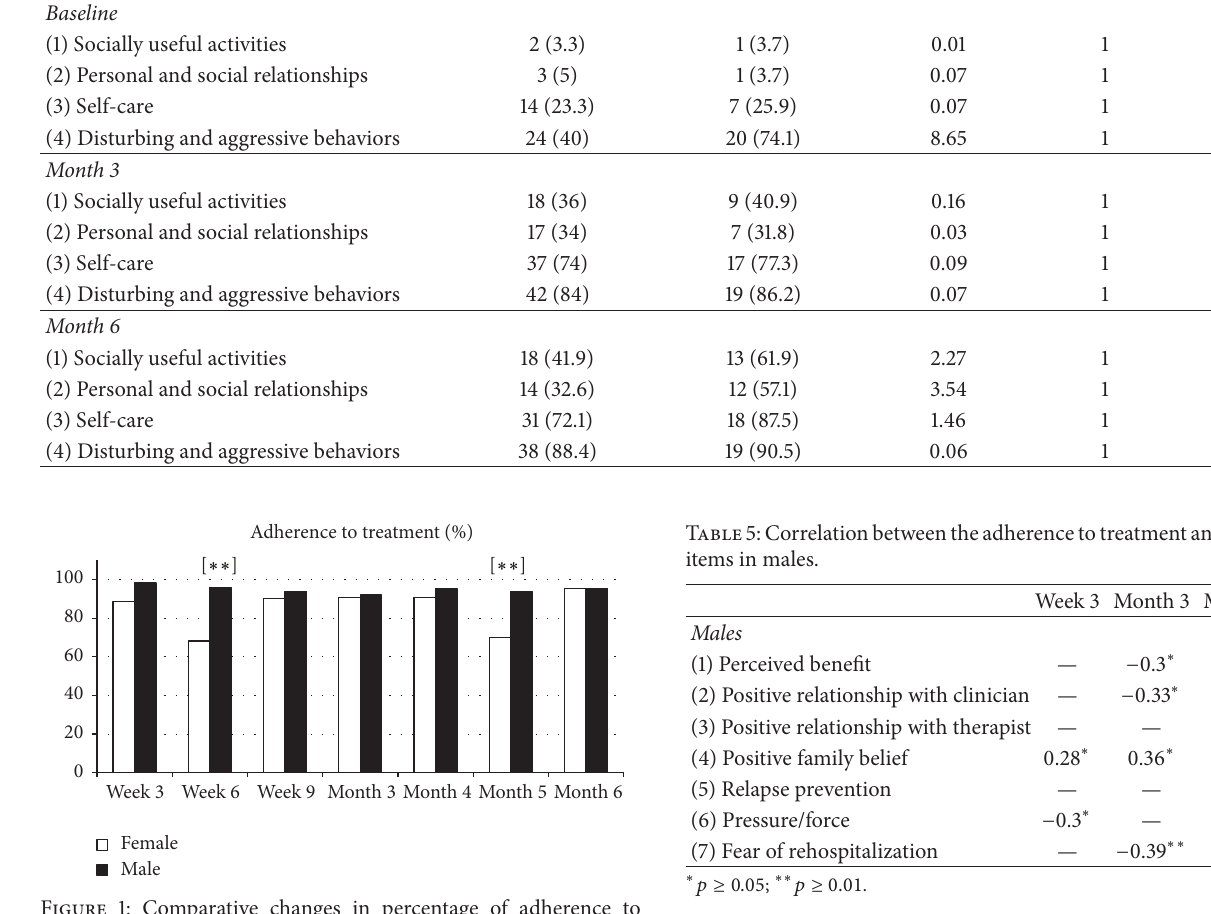
Figure 1: Comparative changes in percentage of adherence to treatment. ∗∗ 𝑝 < 0.01 .